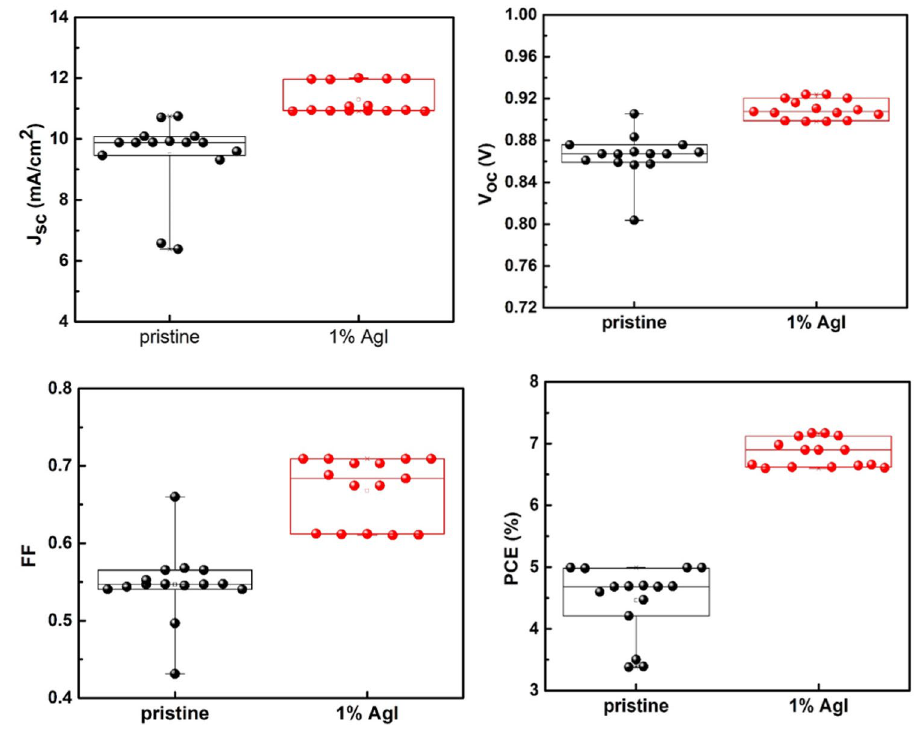
Figure 5. Statistical distribution of PV parameters for the pristine and AgI PSCs, based on 15 cells.